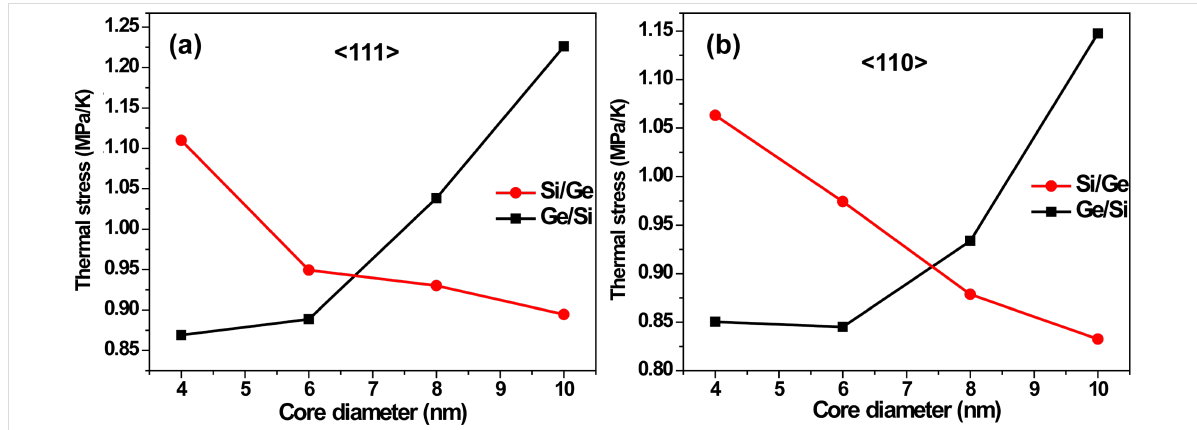
Figure 5: Temperature derivatives of thermal stress at 300 K for the (a) <111>- and (b) <110>-oriented wires of different core diameters.